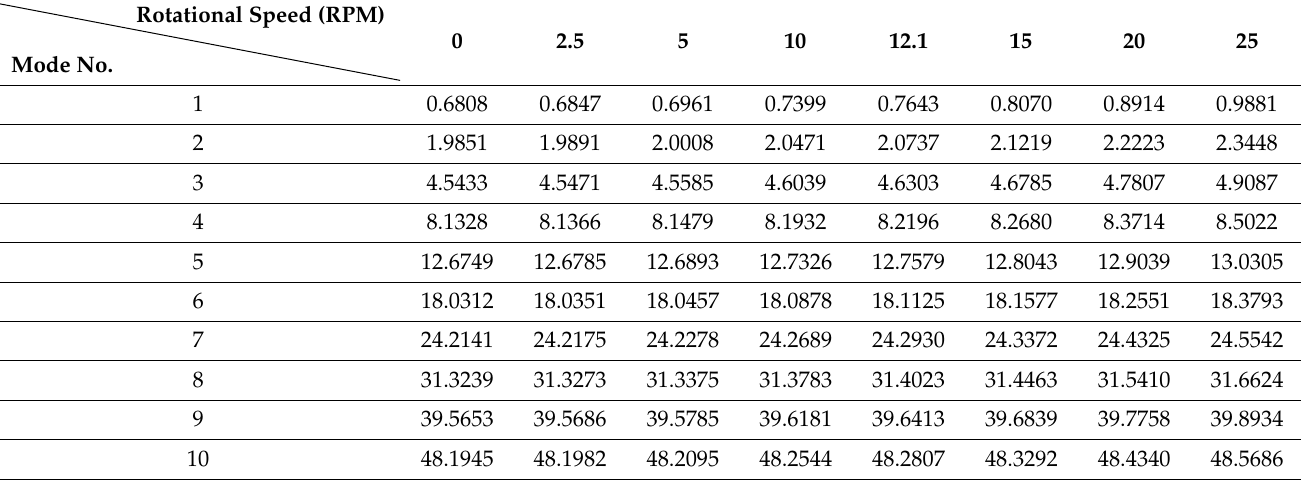
Table 1. The first ten natural frequencies (Hz) variation in the flap-wise direction as a function of rotor speed Ω = ( 0 to 25 RPM ) ) of NREL 5 MW HAWT blade.